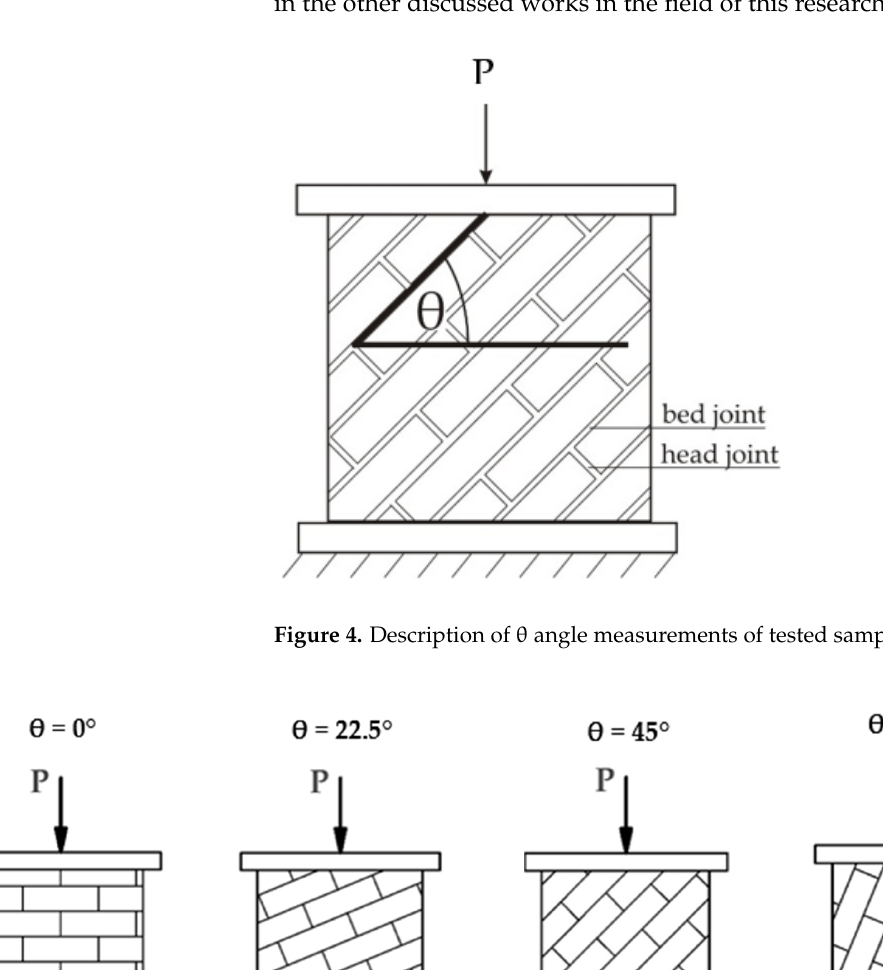
Figure 5. Load application diagram for compressed wall samples at different angles of bed joints ( a ) θ = 0°, ( b ) θ = 22.5°, ( c ) θ = 45°, ( d ) θ = 67.5°, ( e ) θ = 90°.